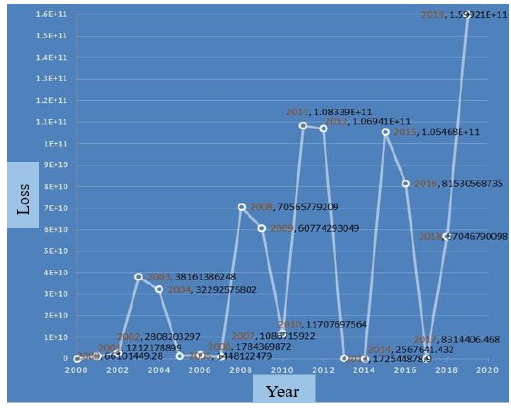
Fig. 2 , Graph of Large Data on Losses Due to Natural Disasters in